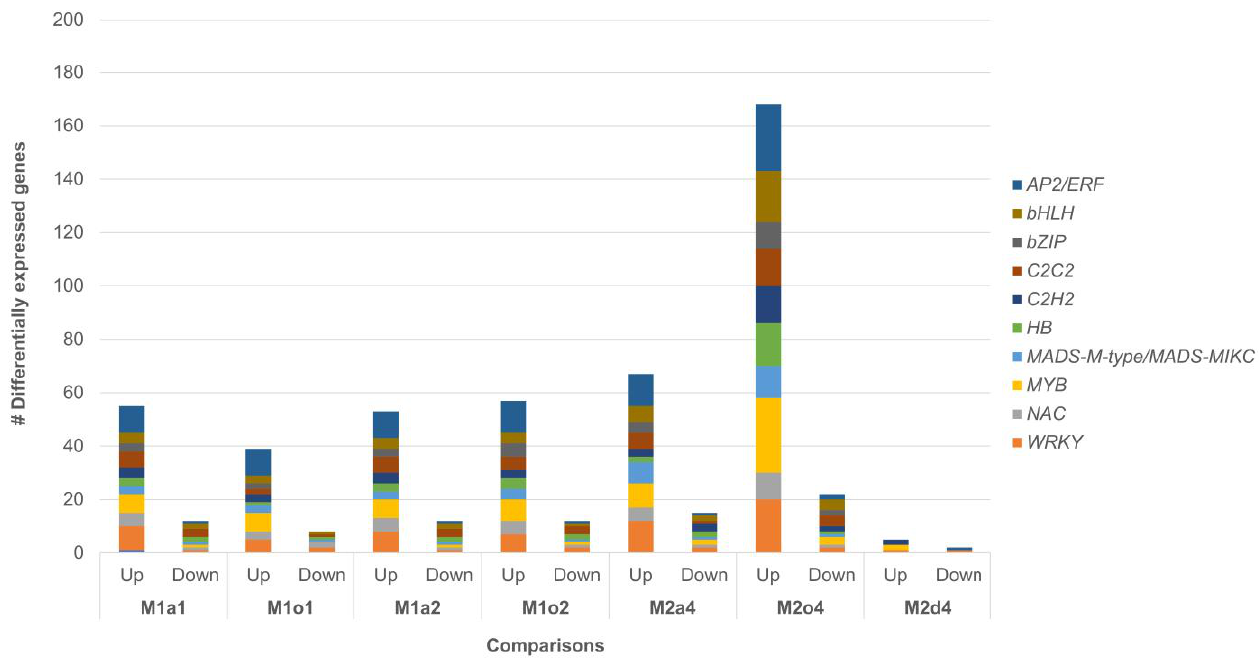
Figure 3. Distribution of differentially expressed transcription factors potentially related to male sterility is classified into the 10 families with the highest number of differentially expressed genes (DEGs) in ovules: Apomictic L. multiflorum (M), sexual L. auriculifolium (a) and L. ovalifolium (o), and facultative apomictic L. dodartii : AP2/ERF , bHLH , bZIP , C2C2 , C2H2 , HB , MADS , MYB , NAC , and WRKY .